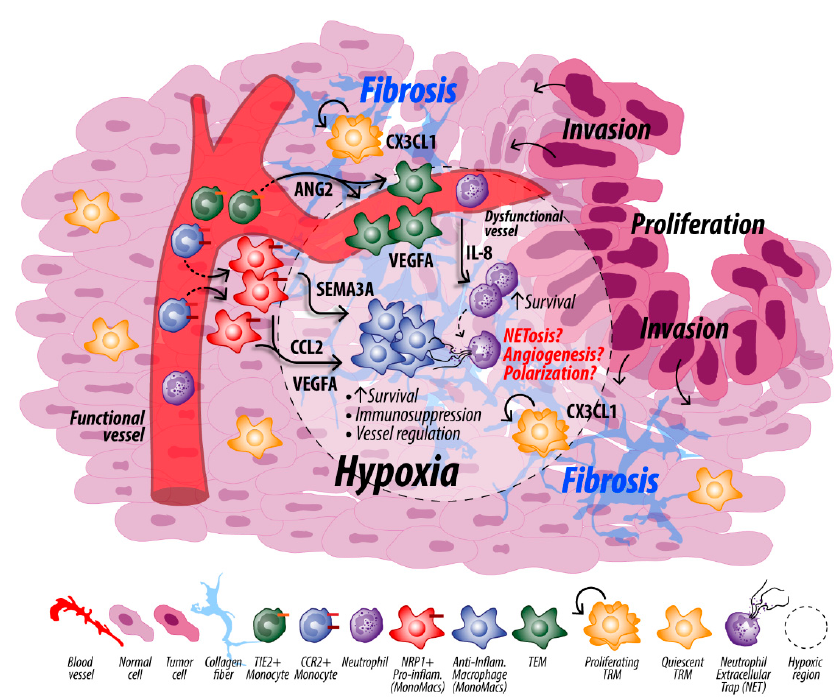
Figure 2. Hypothesized interactions between macrophages and neutrophils in areas of hypoxia. Both macrophages and neutrophils may be recruited to hypoxic regions within the tumor. Additional details about these interactions are discussed in the text.